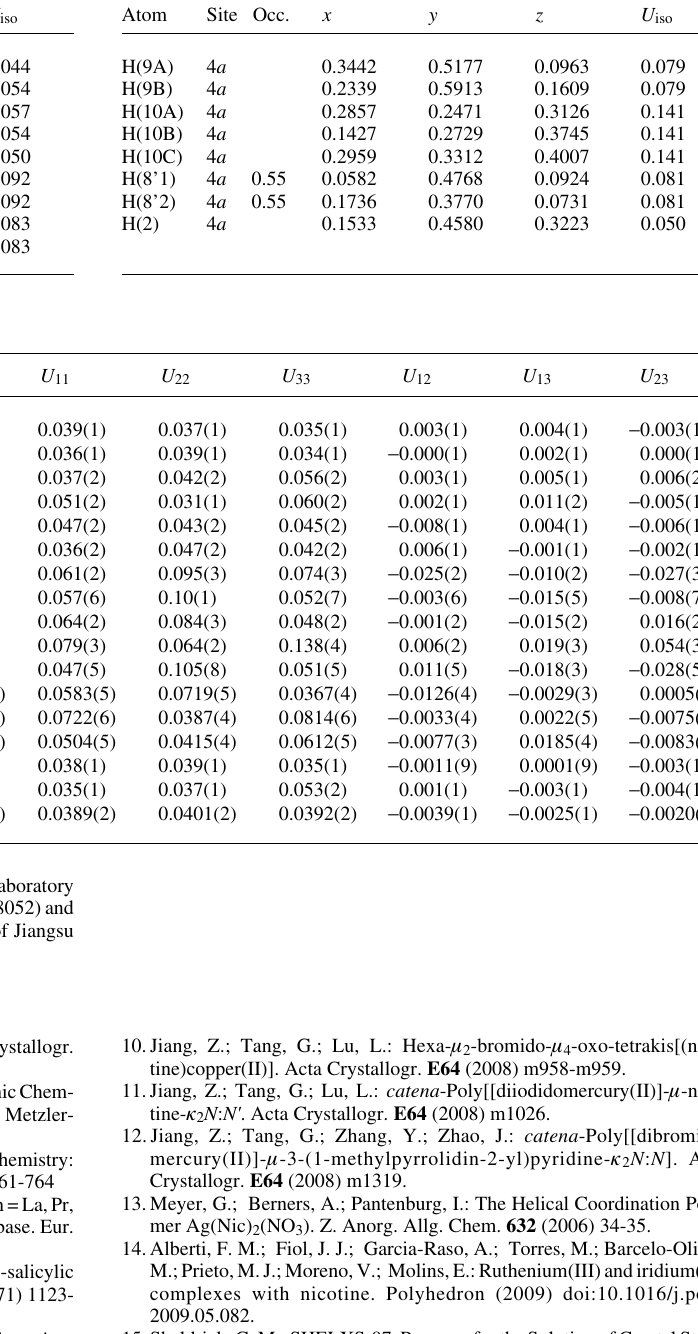
Table 2. Atomic coordinates and displacement parameters (in Å 2 ) . Atom Site